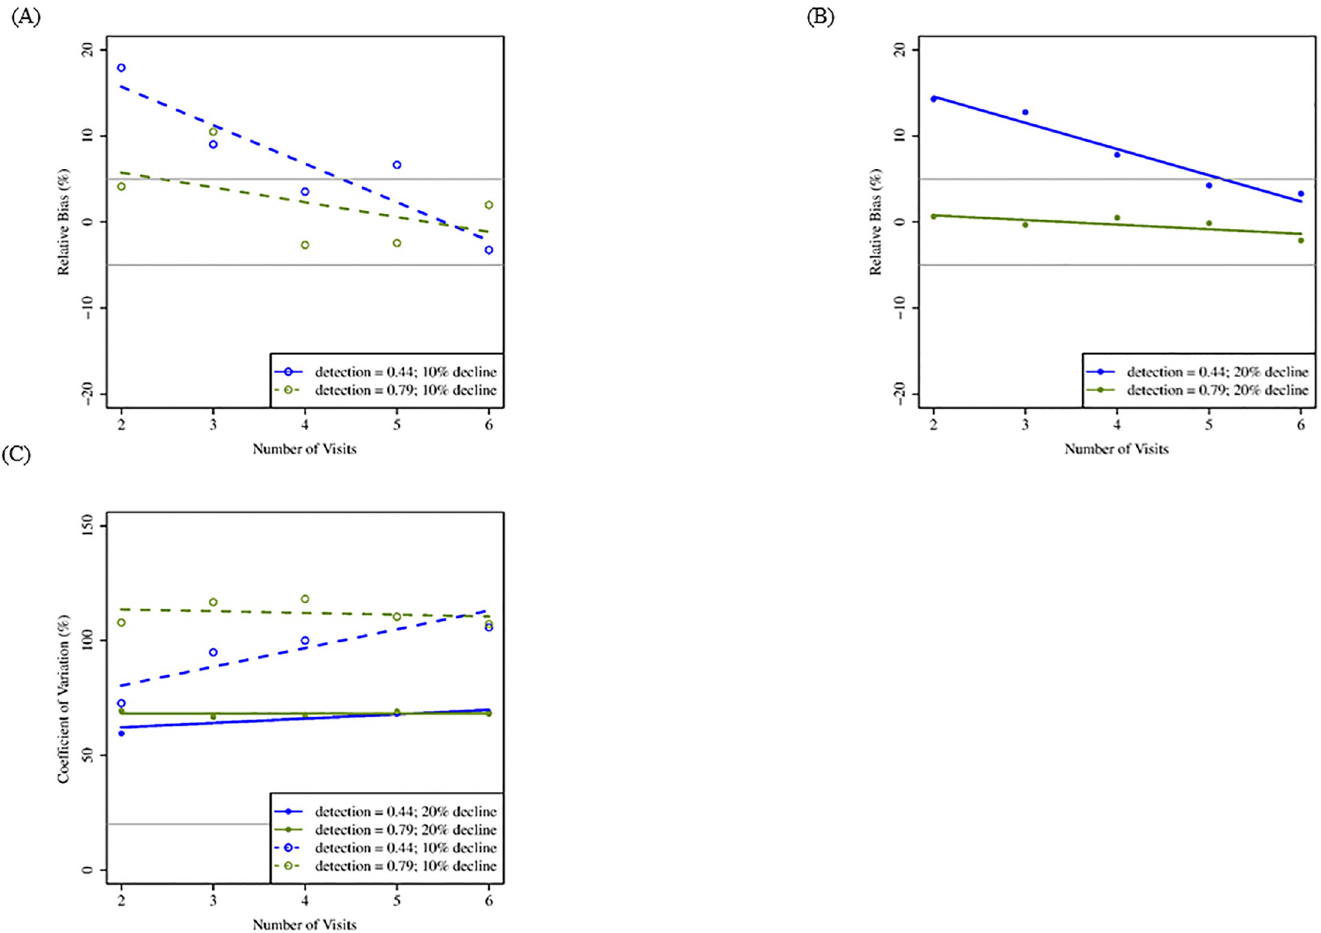
Fig 6. Mean relative bias and coefficient of variation for simulations increasing number of visits (standard design; 10 years). Mean relative bias (A: 10% decline; B: 20% decline) and coefficient of variation (C) for two to six visits to each site, two detection rates, and two rates of population decline following a 10-yr monitoring period, assuming 150 sites and initial probability of occupancy = 0.57. These results reflect a standard sampling design in which all territories are visited an equal number of times within a season. Gray lines indicate benchmark values for respective metrics (Table 2).